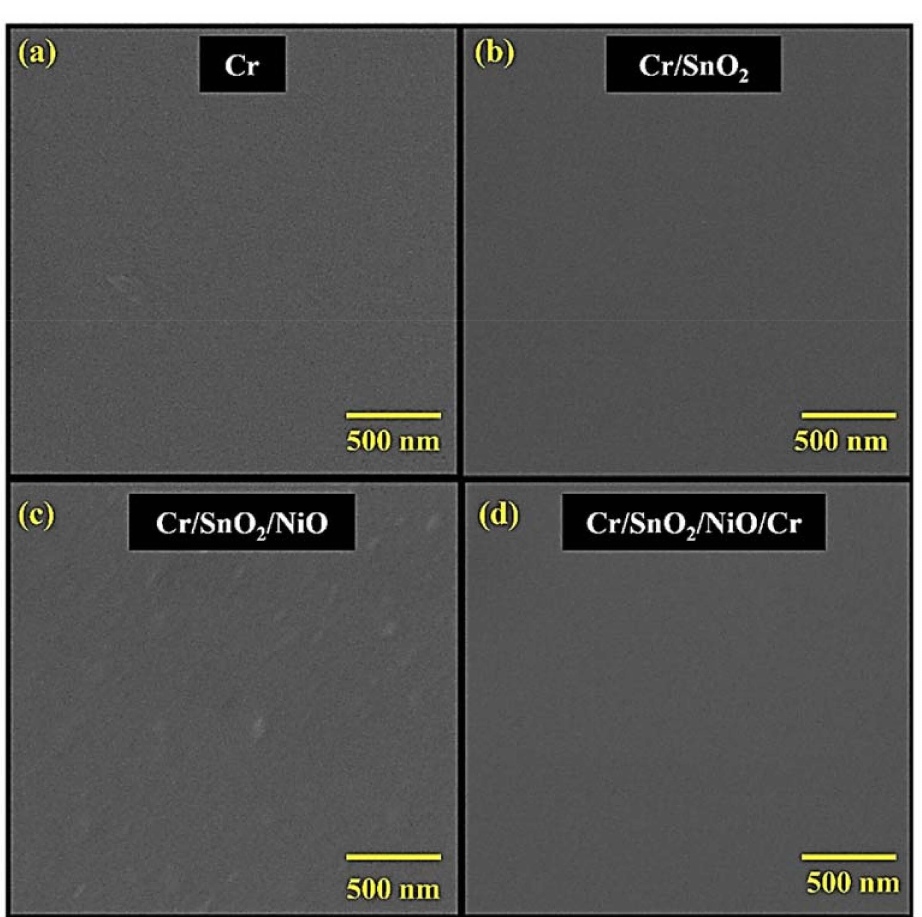
Figure 4. FESEM images of ( a ) Cr, ( b ), Cr/SnO 2 , ( c ) Cr/SnO 2 /NiO, and ( d ) Cr/SnO 2 /NiO/Cr coatings,